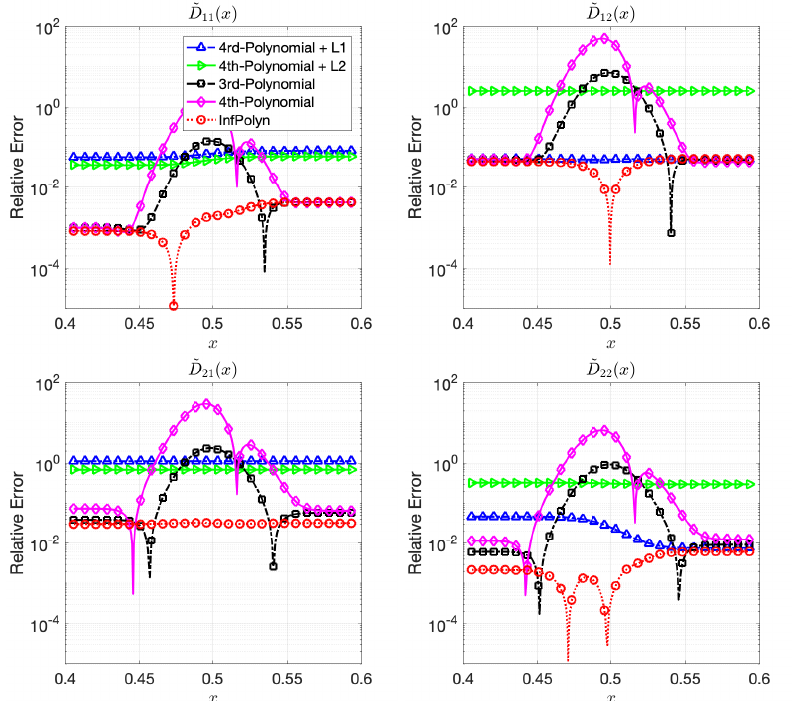
Figure 1. The relative errors (REs) of predictive diffusion coefficients ˜ D ij ( c ( x )) in the center areas x ∈ [ 0.4,0.6 ] for the evaluated methods in a random ternary system.